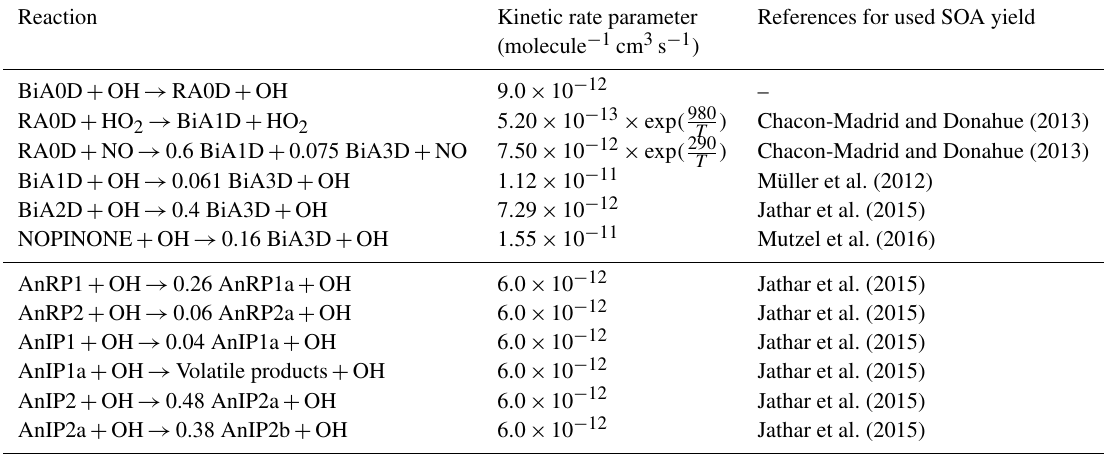
Table 7. Aging mechanism of SVOCs ∗ .